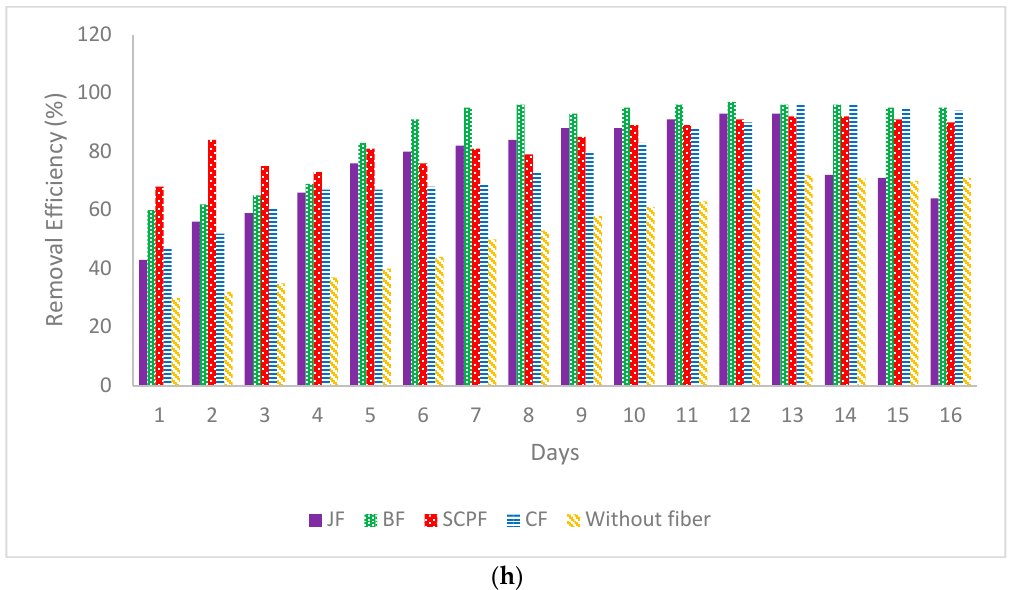
Figure 2. Daily monitoring for the removal efficiency of ( a ) BOD, ( b ) COD, ( c ) ammonia-nitrogen, ( d ) phosphate, ( e ) NO 2 , ( f ) NO 3 , ( g ) Oil-grease, ( h ) TSS, in all reactors.